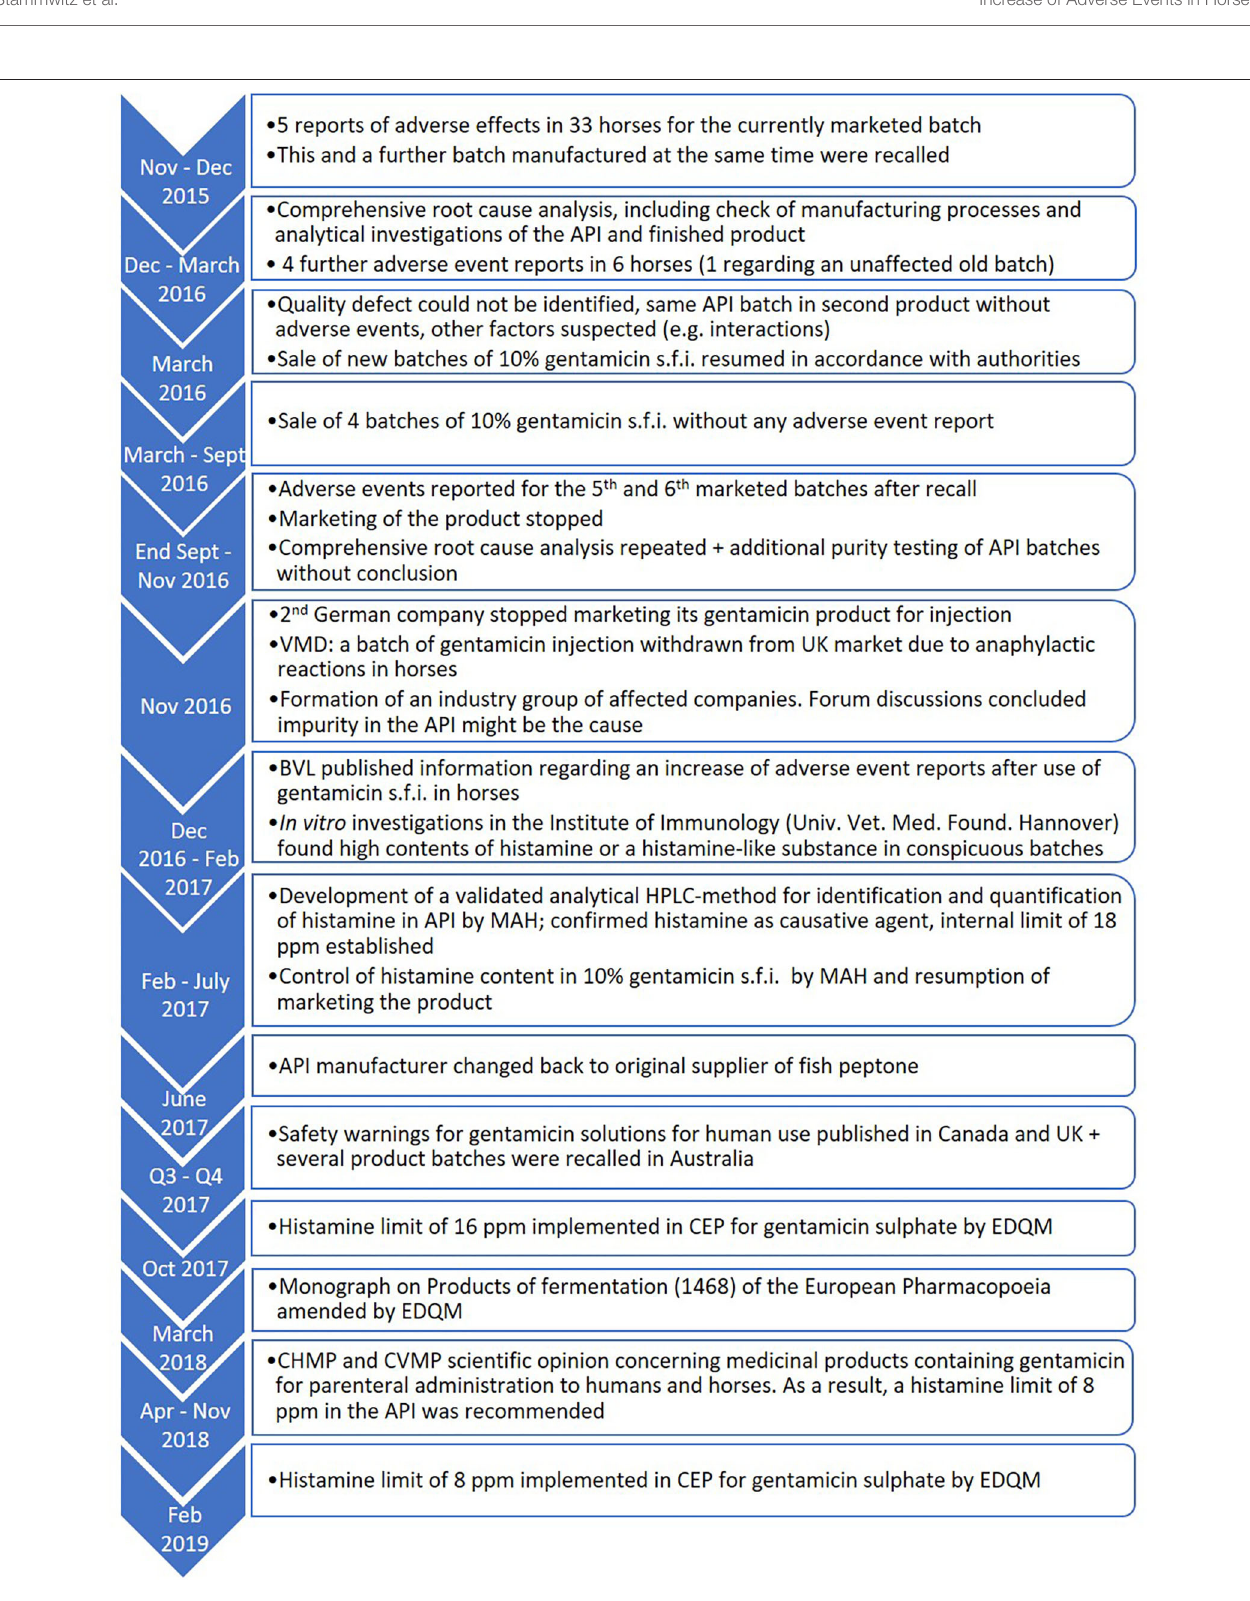
FIGURE 1 | Timeline of events regarding the safety of gentamicin between 2015 and 2019. It should be noted that this figure is not exhaustive and serves for orientation only.